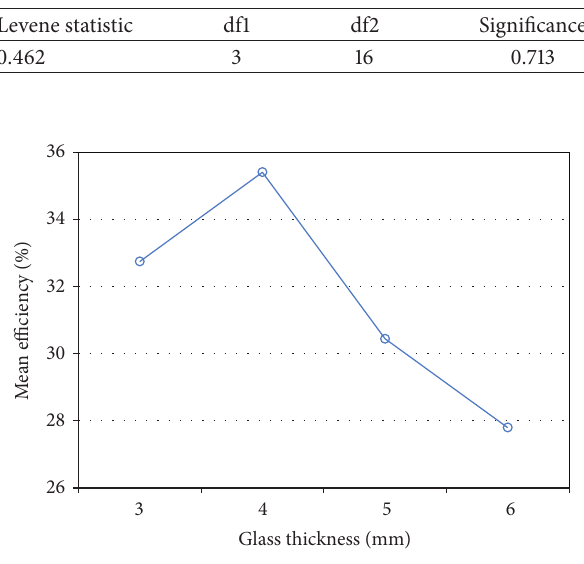
Figure 7: Means plot of performances of solar collectors with different glass